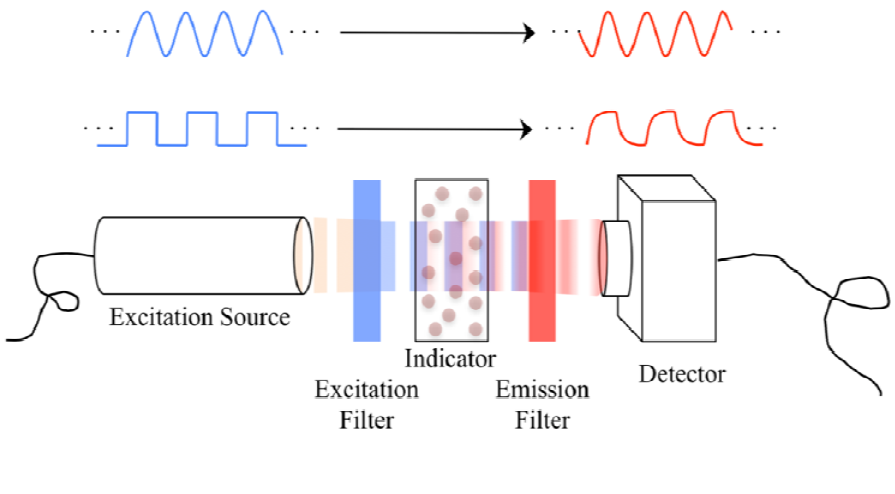
Figure 2. Simplified example setup for lifetime-based optical oxygen sensing. Example excitation modulation and emission waveforms are also